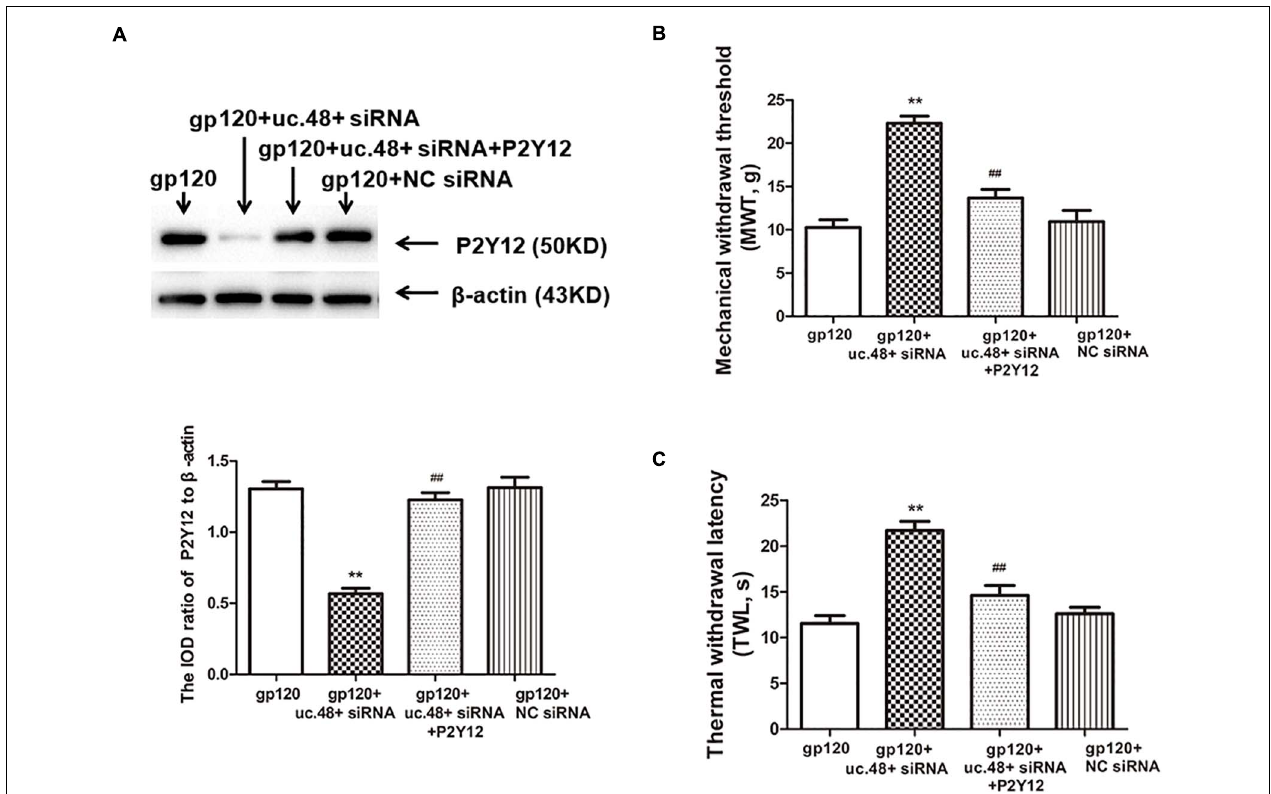
FIGURE 5 | Overexpression of P2Y12 rescued effects of uc.48+ siRNA treatment on downregulated expression of P2Y12 receptor and hyperalgesia in gp120 group. (A) Western blotting results showed that downregulation of DRG P2Y12 protein in gp120-treated rats with uc.48+ siRNA was significantly rescued by overexpression of P2Y12. (B,C) Upregulation of MWT and TWL was rescued by overexpression of P2Y12. n = 10 rats per group. Data are displayed as means ± SEM. ∗∗ p < 0.01 vs. gp120-treated rats, ## p < 0.01 vs. gp120-treated with uc.48+ siRNA